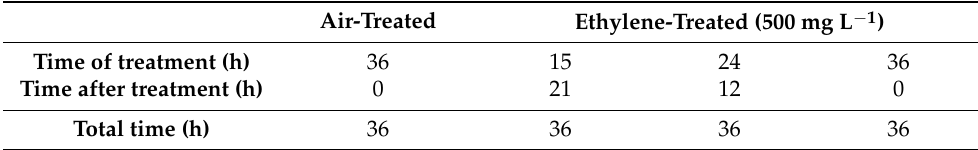
Table 1. Schematic protocol of treatments. Time of treatments represents the hours of grape perma- nence at treatment conditions (ethylene or air) inside the chambers. Time after treatments is the time of prolonged grape permanence inside the chambers, over treatment conditions, for reaching the same total time of 36 h.